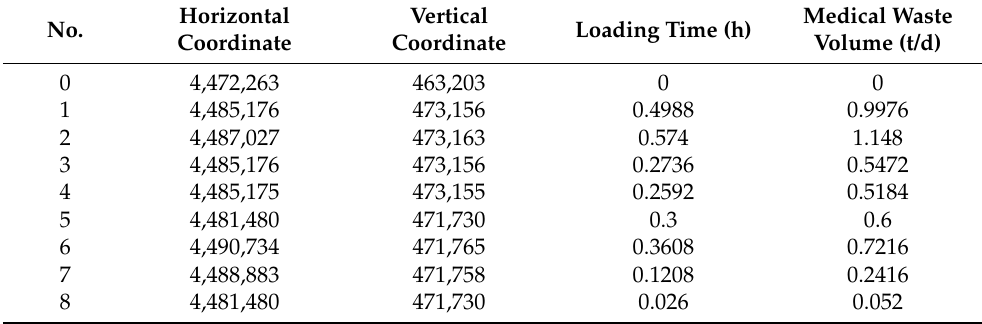
Table A1. The coordinates, loading time, and daily waste production of 109